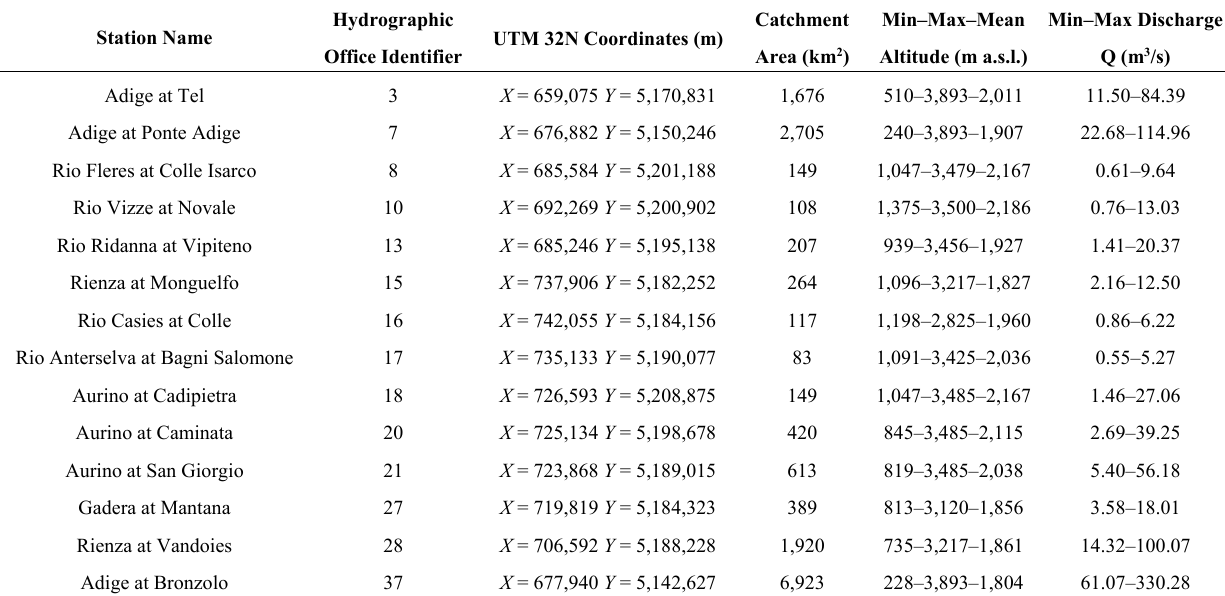
Table 1. Main characteristics of selected discharge measurement